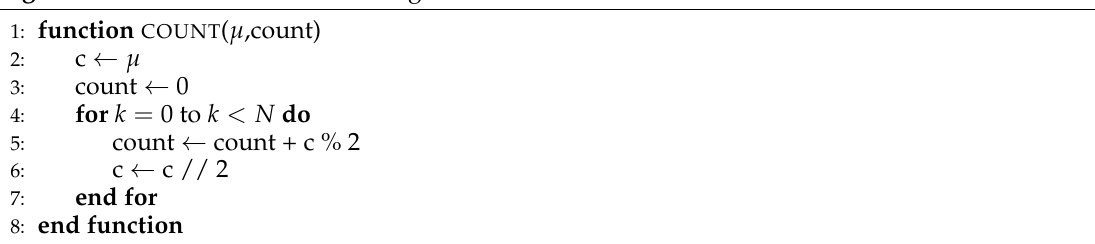
Algorithm A2. Number of Infected Agents